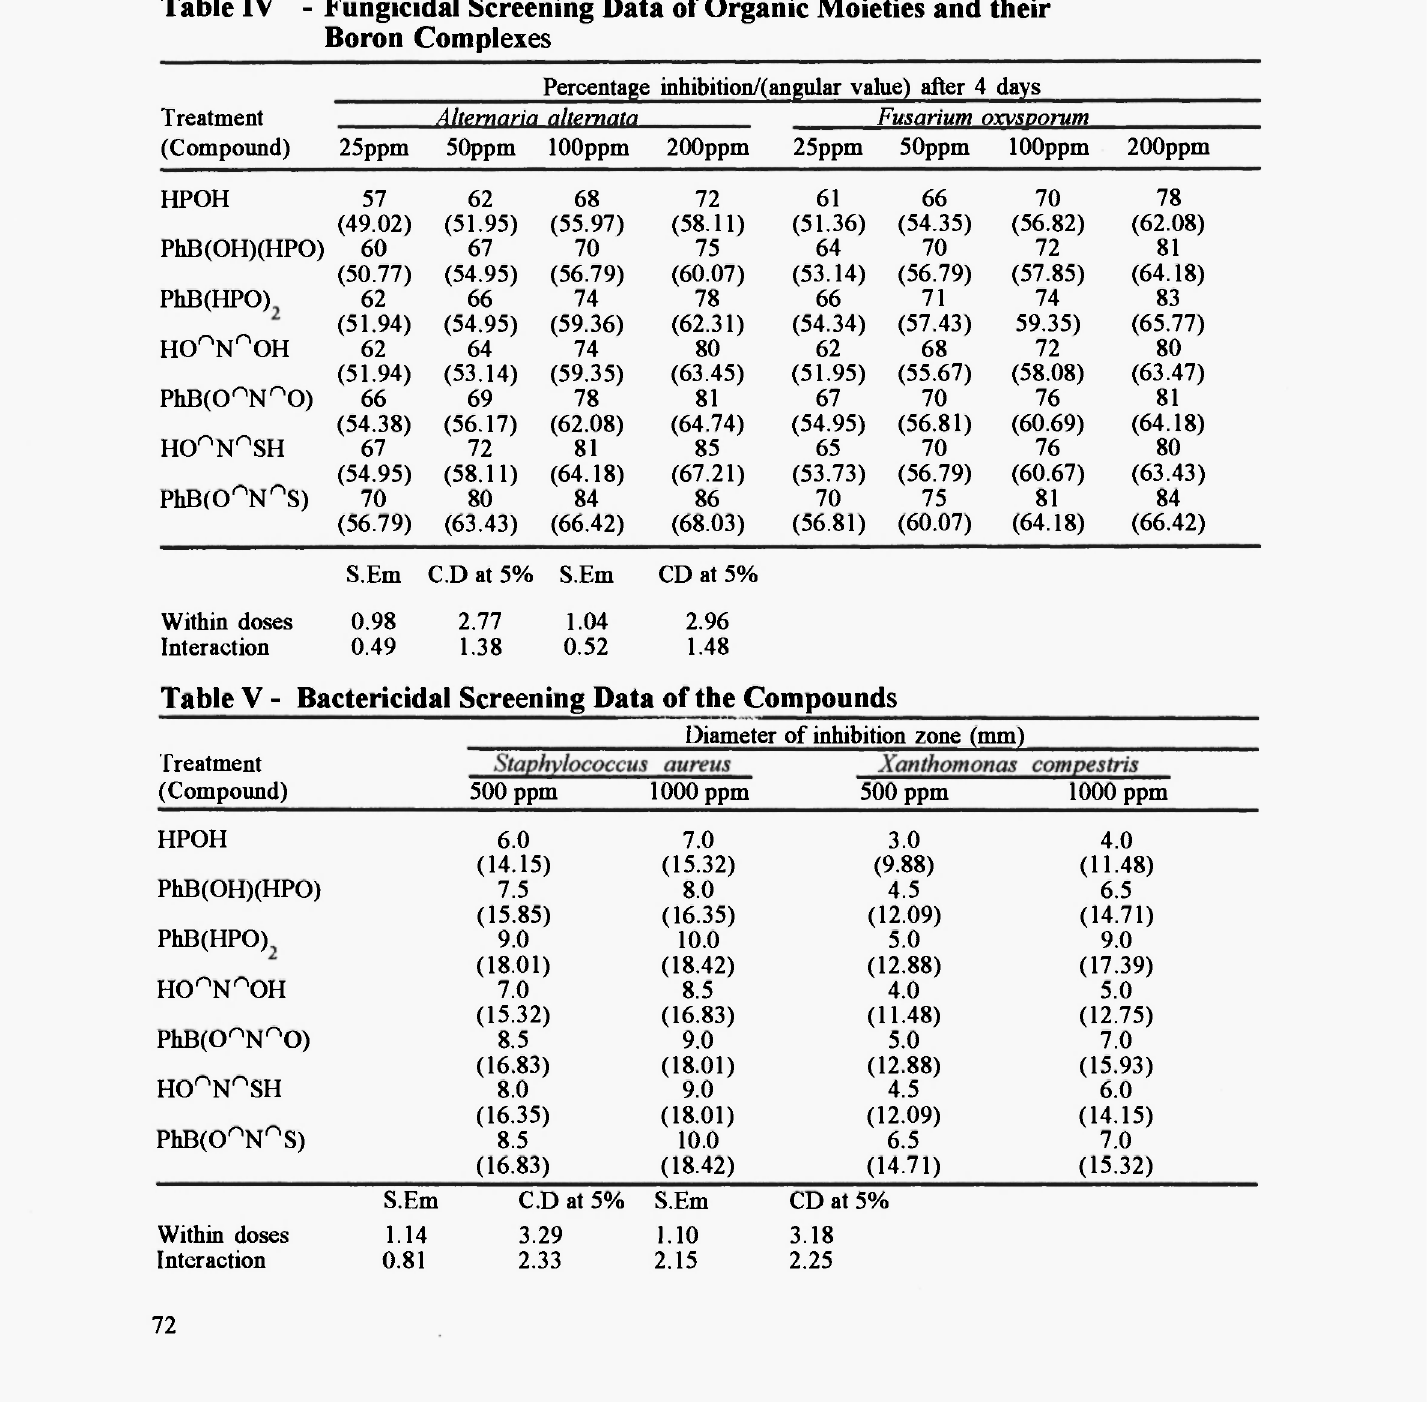
- Fungicidal Screening Data of Organic Moieties and their Boron Complexes